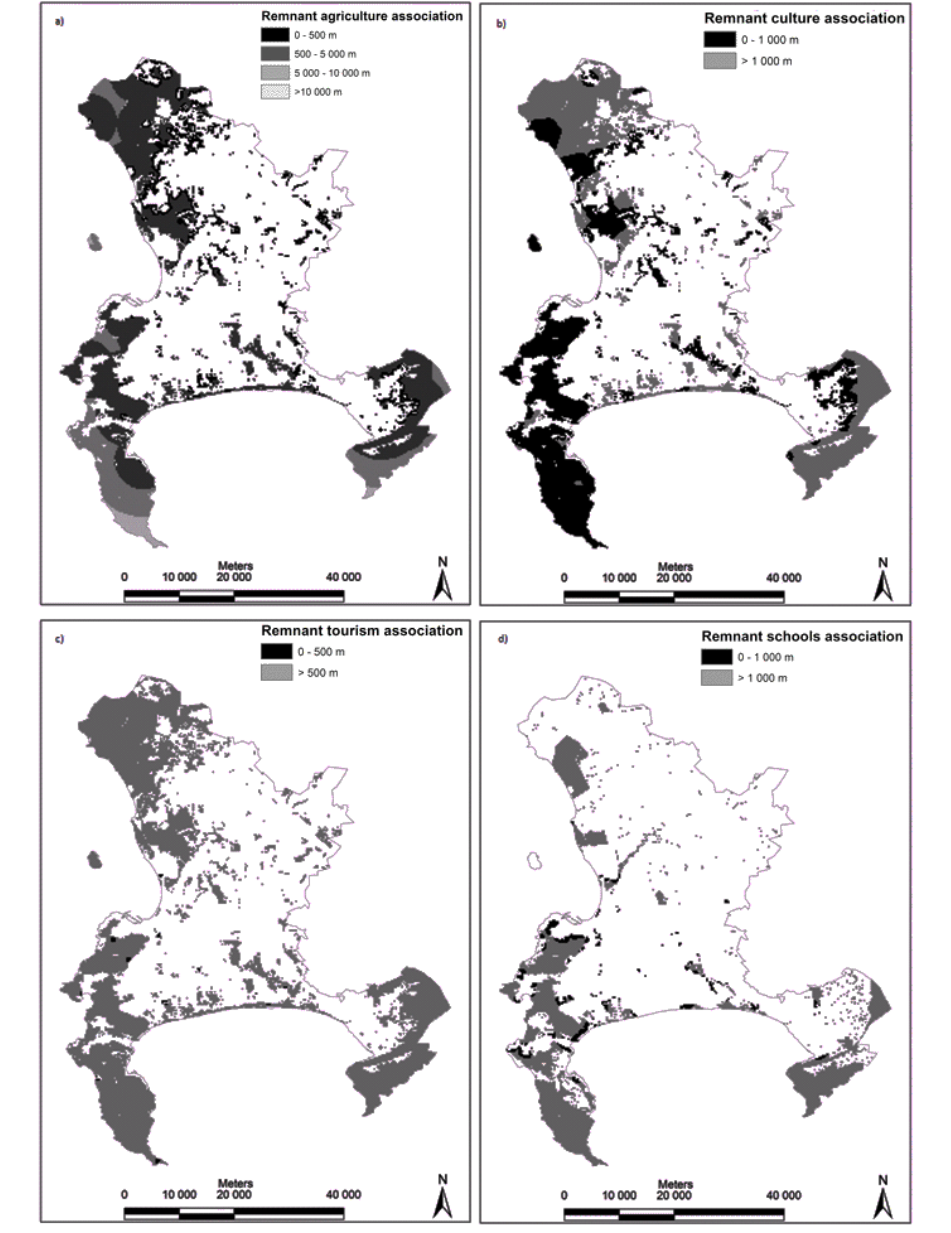
Fig. 4 . Natural remnant vegetation association with distance from a) agricultural sites, b) cultural sites, c) tourism stop-off points, d)